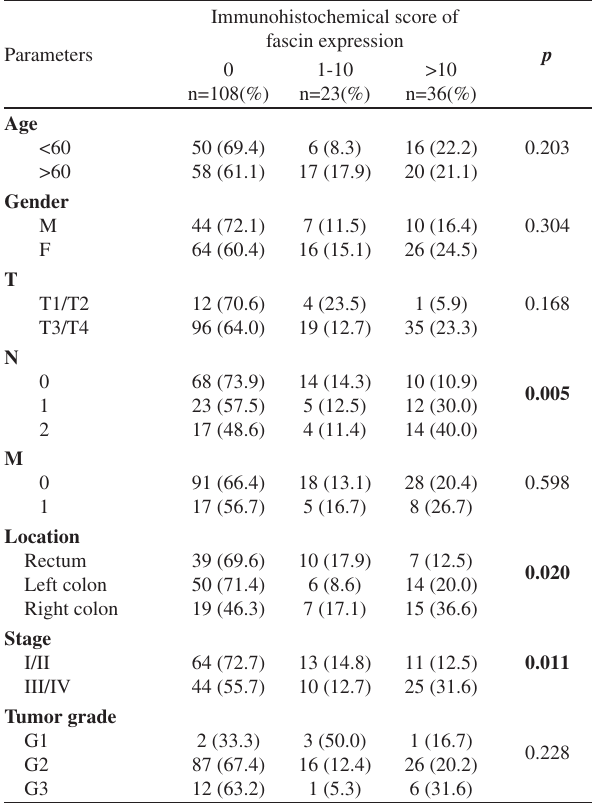
Table 4 - Immunohistochemical scores of fascin expression in colorectal carcinomas Immunohistochemical score of fascin Parameters